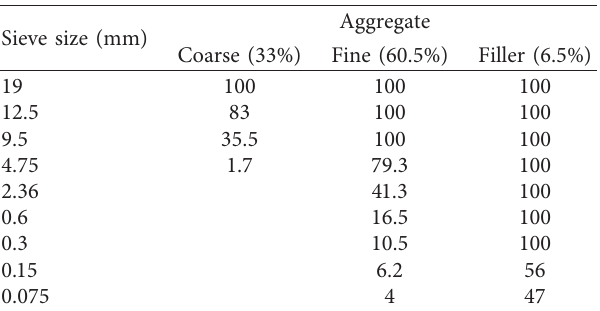
Table 1: Aggregate